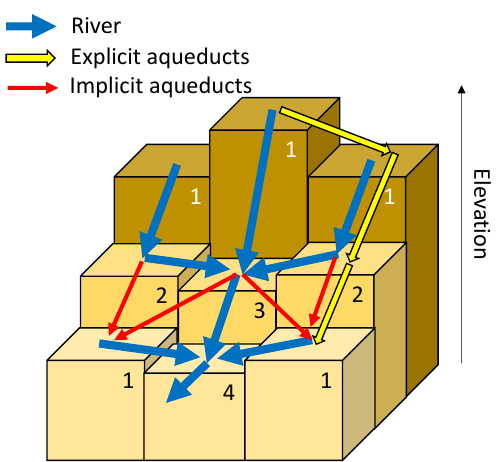
Figure 3. Schematic diagram of aqueduct water transfer for hypo- thetical 3 × 3 grid cells. Blue arrows delineate the river channel. Yellow and red arrows represent explicit and implicit aqueducts, re- spectively. The height and number of boxes indicate elevation and the river sequence number. The river sequence increases as the river flows downstream. Water transfer via implicit aqueducts is only as- sumed to be possible if the elevation and river sequence of the origin are greater than the destinations within the same